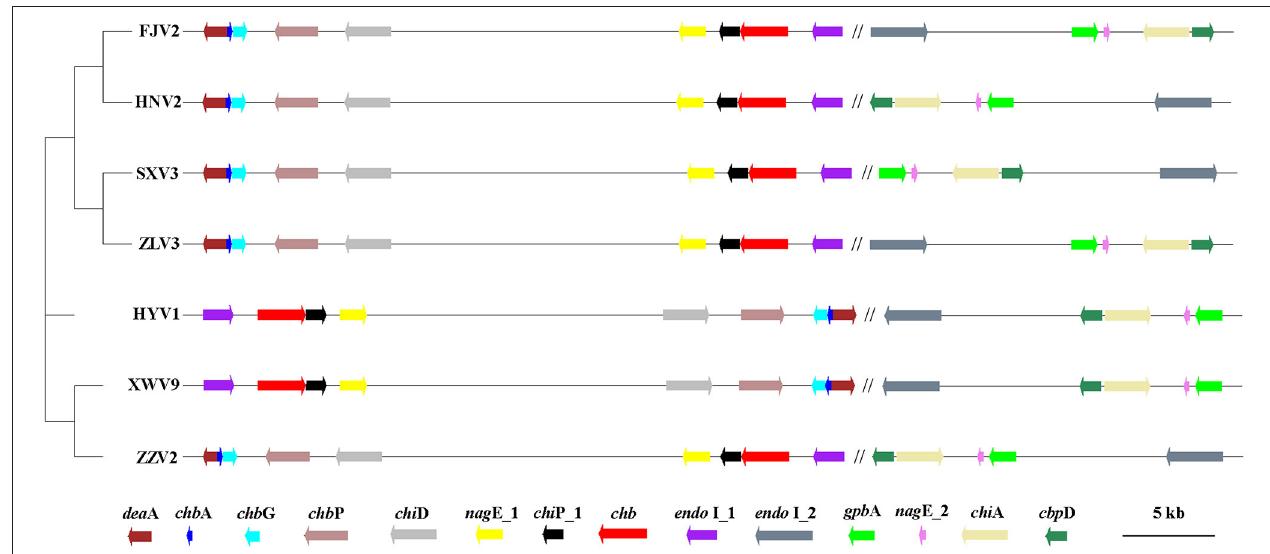
FIGURE 8 | The phylogenetic tree generated using the neighbor-joining method based on the alignment of 14 single-copy genes involved in chitin-degradation pathway of the seven V. alginolyticus strains. The first nine genes locate on chromosome I, which being separated by symbol “//” from other five genes on chromosomes II. Arrows to the left and to the right indicate genes encoded on the plus and minus DNA strands, respectively. The scale bar indicates the size of genes, while the distances between genes was reduced by 100 times. Gene annotation: endo I_1 and endo I_2: Chitodextrinase; chb , N , N ’-diacetylchitobiase; chi P_1: chitoporin; nag E_1/ nag E_2, PTS system N -acetylglucosamine-specific EIICBA component; chi D, Chitinase D; chb P, N , N’ -diacetylchitobiose phosphorylase; chb G, Chitooligosaccharide deacetylase ChbG; chb A, PTS system N , N’ -diacetylchitobiose-specific EIIA component; dea A, chitin disaccharide deacetylase; gbp A,